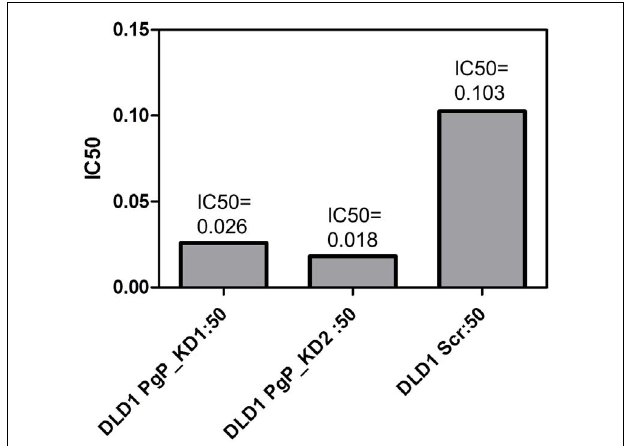
FIGURE 4 | Knockdown of P-gp by shRNA in DLD-1 cells increased the potency of PF-3758309. A four to six fold shift in the IC50 was achieved through the knockdown of